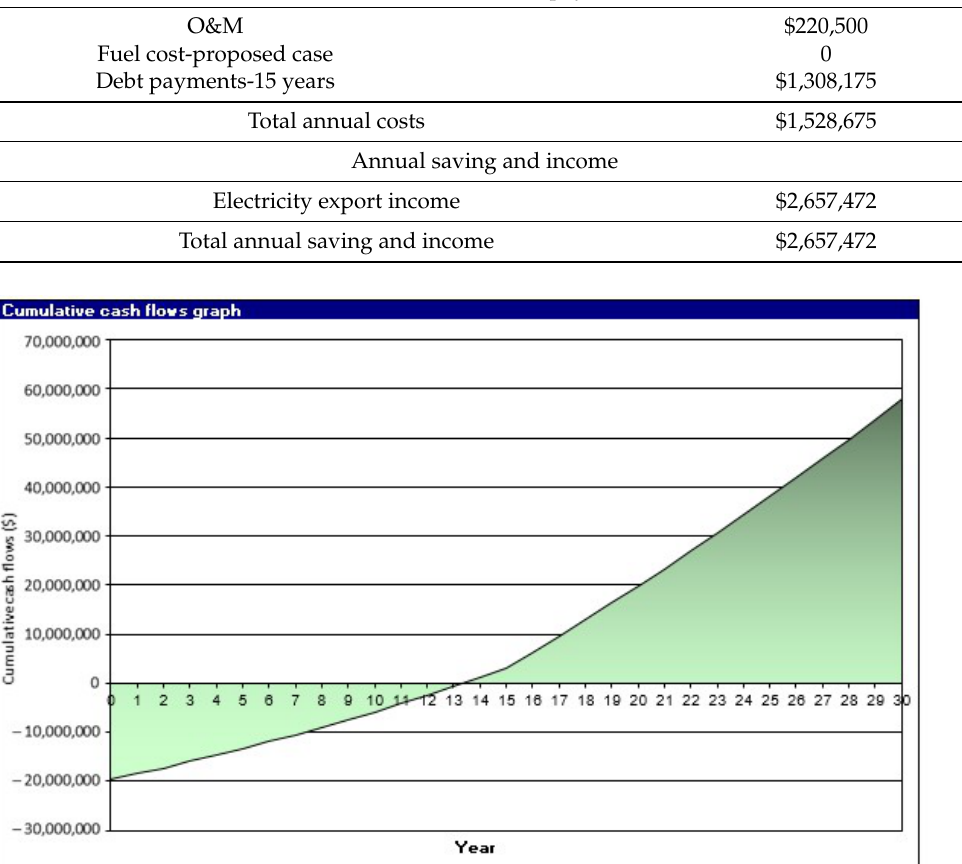
Figure 6. Return on investment, and long-term cash-flow, for Scenario